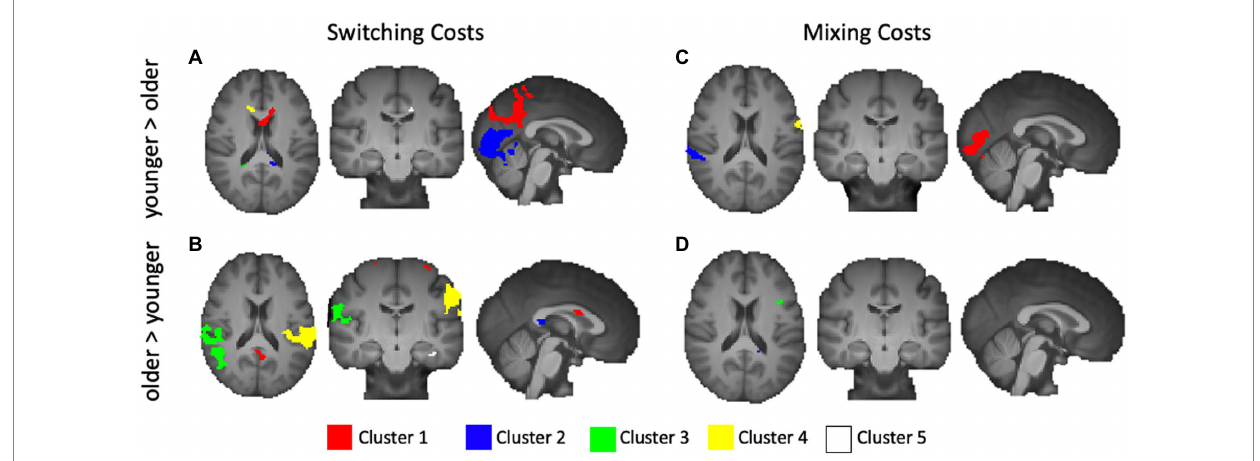
FIGURE 4 Activations from age-group level contrasts for switching and mixing costs. (A) Younger > Older Switching Cost; (B) Older > Younger Switching Cost; (C) Younger > Older Mixing Cost; and (D) Older > Younger Mixing Cost. Only the five largest clusters for each contrast are rendered. Details of each cluster are shown in Table 2, with colors representing separate clusters according to size: Cluster 1 = Red, Cluster 2 = Blue, Cluster 3 = Green, Cluster 4 = Yellow, Cluster 5 =